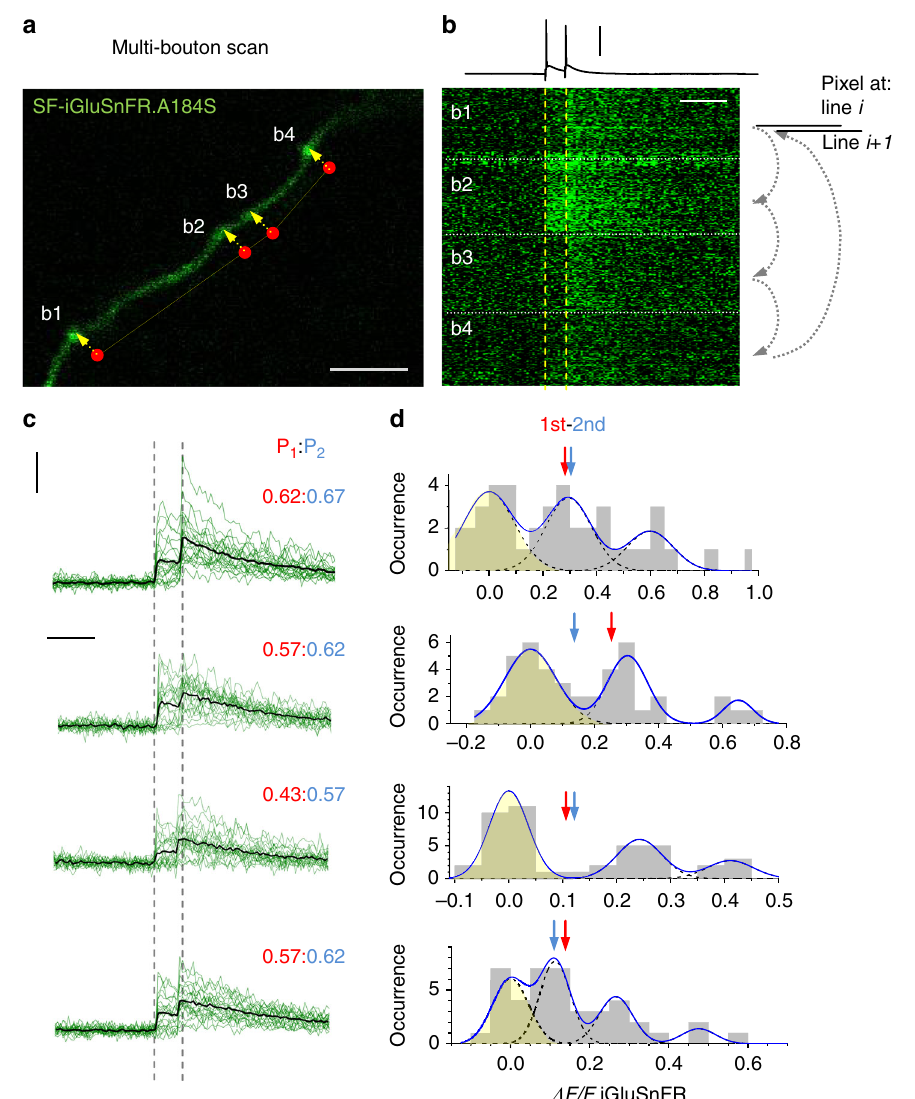
Fig. 2 Multi-synapse imaging of quantal glutamate release with SF-iGluSnFR.A184S. a CA3 pyramidal cell axon fragment in area CA1 showing four presynaptic boutons (b1 – b4); the scanning dwell points in the bouton centres (red dots, dwell-delay time ~1.5 ms per bouton) and laser scan trajectory (dotted yellow line) illustrated; scale bar, 5 µ m. b A pseudo-linescan image of SF-iGluSnFR.A184S signals recorded simultaneously (one sweep example) at four boutons shown in a as indicated, during somatic generation of two action potentials 50 ms apart (top trace, current clamp). Arrow diagram relates displayed pixels to the scanning cycle: pixels at each displayed i th line are recorded sequentially among boutons (small arrows), and the next cycle fi lls the ( i + 1 )th line of the display. Thus a pseudo-linescan image is generated showing brightness dynamics at individual boutons, with ~1.5 ms resolution; glutamate releases and failures can be seen; scale bars, 60 mV (vertical) and 100 ms (horizontal). c A summary of 22 trials in the experiment shown in a , b ; green traces, single-sweep SF-iGluSnFR.A184S intensity readout at the four bouton centres; black traces, all-sweep-average; P 1 : P 2 , average probability P fi rst (red) and second (blue) release events; scale bars, 50% Δ F/F (vertical) and 100 ms (horizontal). d Amplitude r (release success rate) of the histograms (SF-iGluSnFR.A184S Δ F/F signal, fi rst and second response counts combined; prepulse baseline subtracted) with a semi-unconstrained multi- Gaussian fi t (blue line, Methods) indicating peaks that correspond to estimated quantal amplitudes; the leftmost peak corresponds to zero signal (failure; yellow shade); dotted lines, individual Gaussians; arrows, average amplitudes (including failures) of the fi rst (red) and second (blue) glutamate